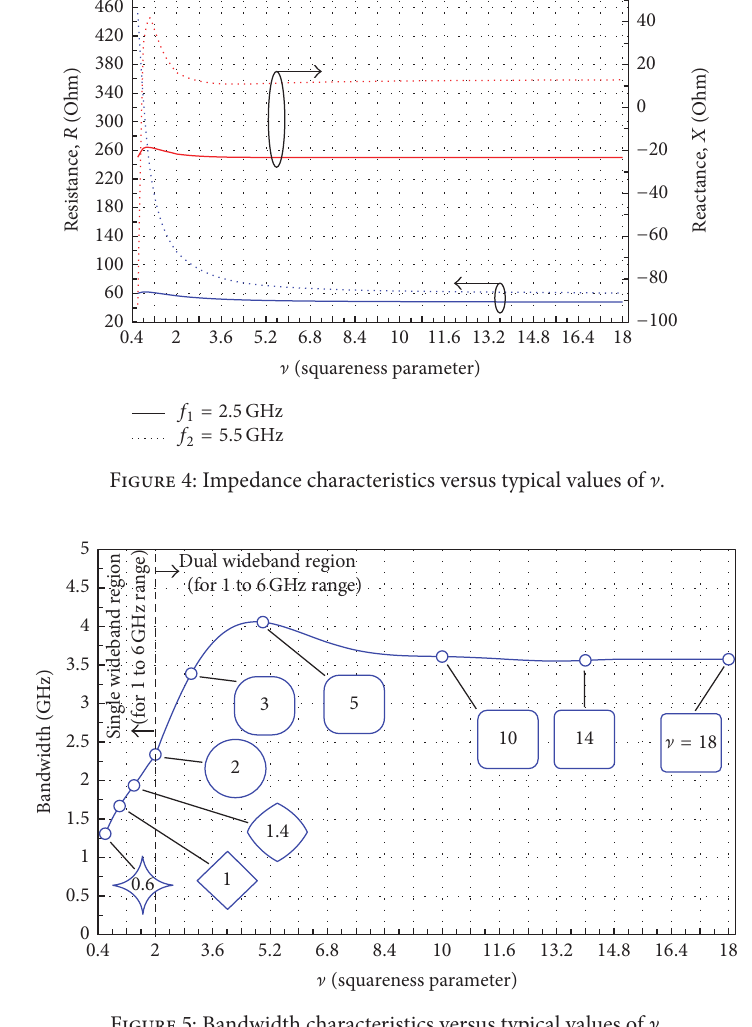
Figure 5: Bandwidth characteristics versus typical values of ]